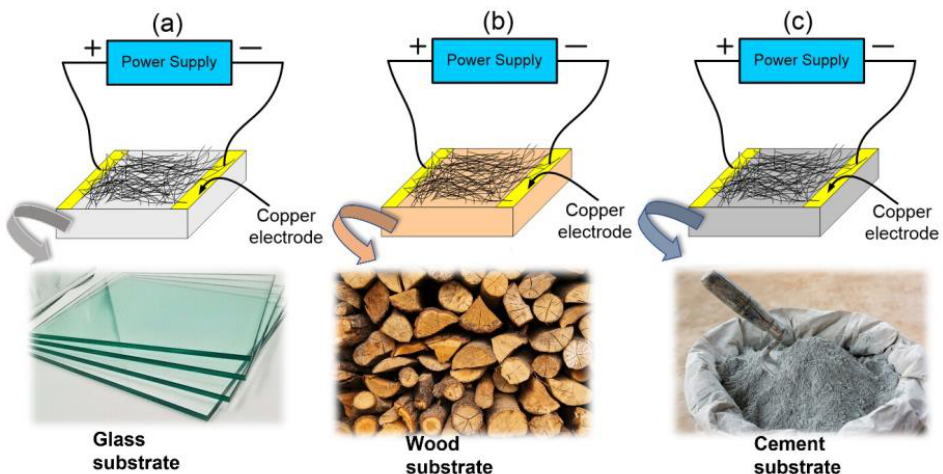
Figure 2. A cartoon illustrating the structure of the heater devices fabricated with ( a ) AgNWs/glass; ( b ) AgNWs/wood; and ( c ) AgNWs/cement.